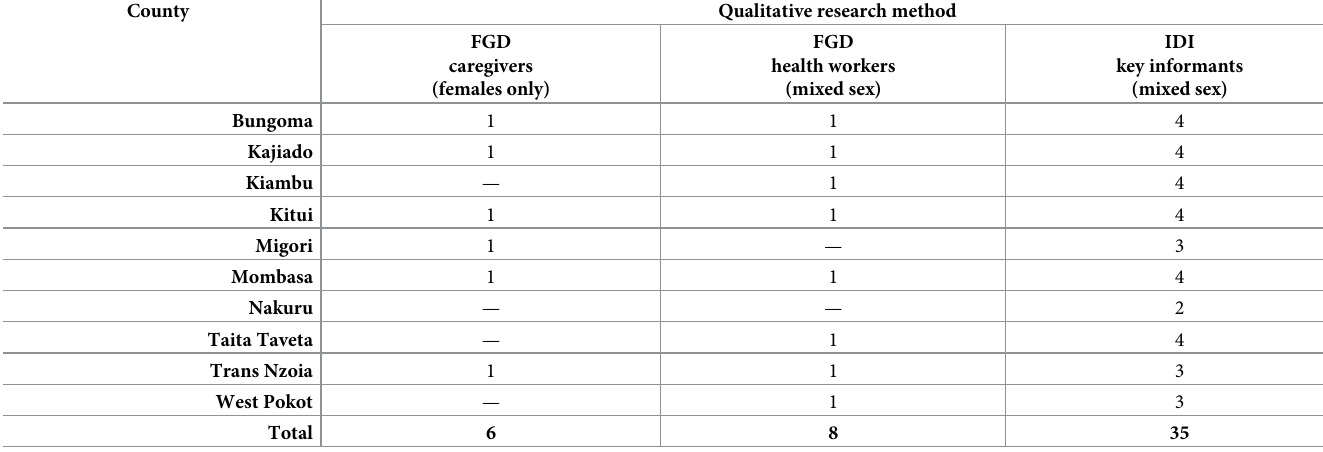
Table 1. Qualitative data collected during the Kenya missed opportunities for vaccination assessment, by county, November 2016.